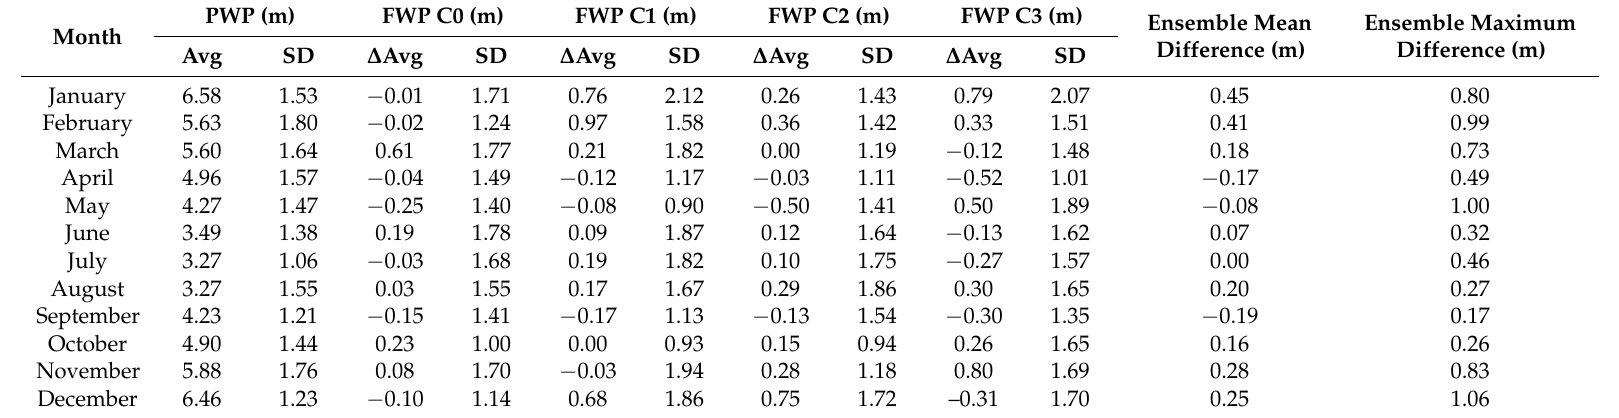
Table 1. Pembroke comparison of present (PWP) and future (FWP-C0–C3) H s max